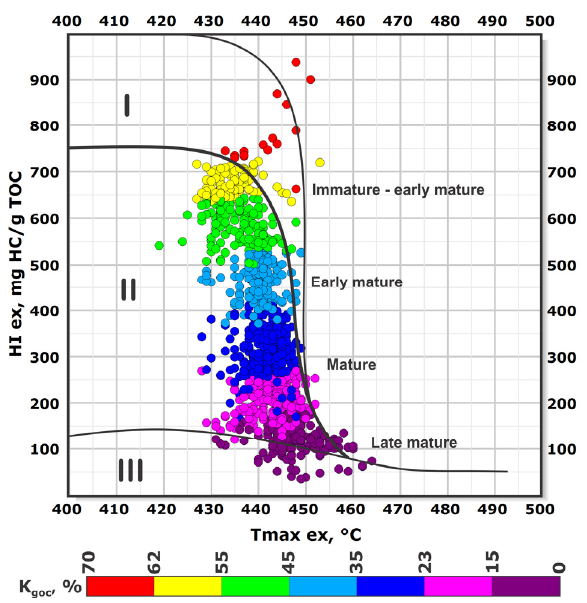
Figure 3. Modified van Krevelen diagram for the studied sample collection. Values of HI ex and Tmax ex were determined for samples after extraction with chloroform. The color indicates the proportion of generative kerogen K goc = (GOC ex /TOC ex ) × 100, %. Lines divide samples into: I—type I kerogen, II—type II kerogen, III—type III kerogen.